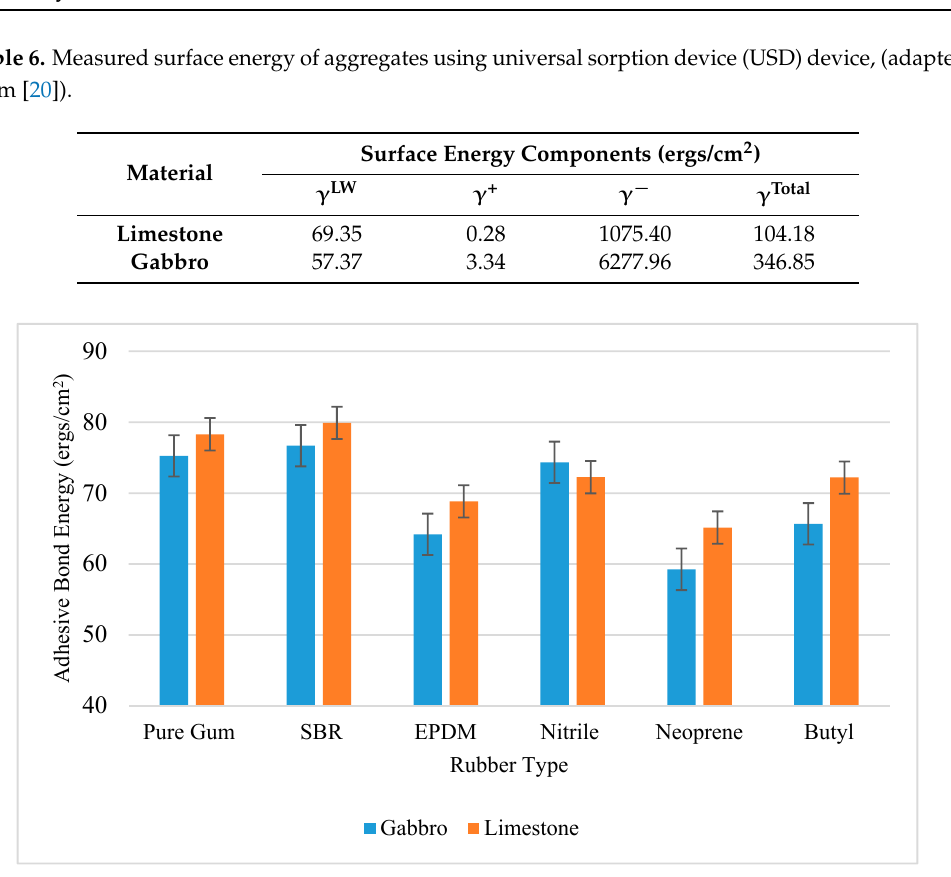
Figure 8. Adhesive bond energy between rubbers and aggregates materials.